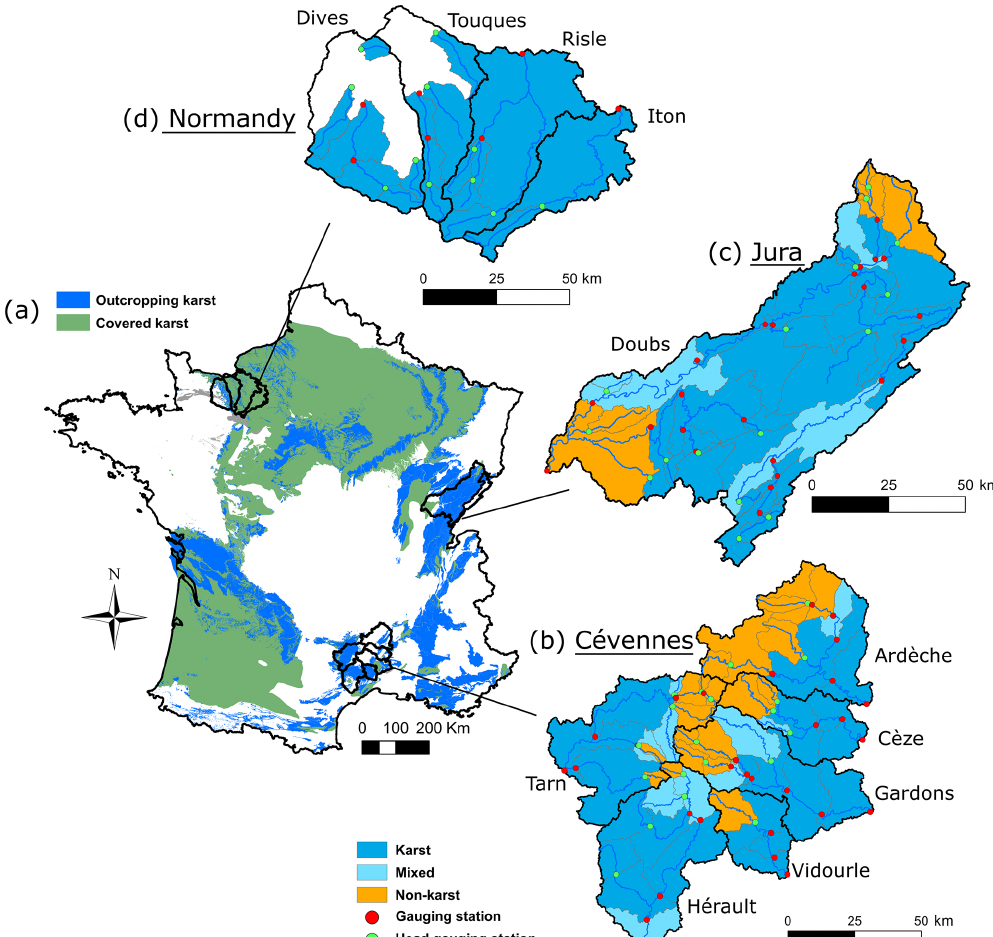
Figure 4. (a) Location of the studied areas with karst regions in France (from BDLISA database). (b, c, d) Distribution of gauging stations and geology type of elementary catchments. Red circles indicate gauging stations in intermediate catchments; green circles indicate gauging stations in headwater